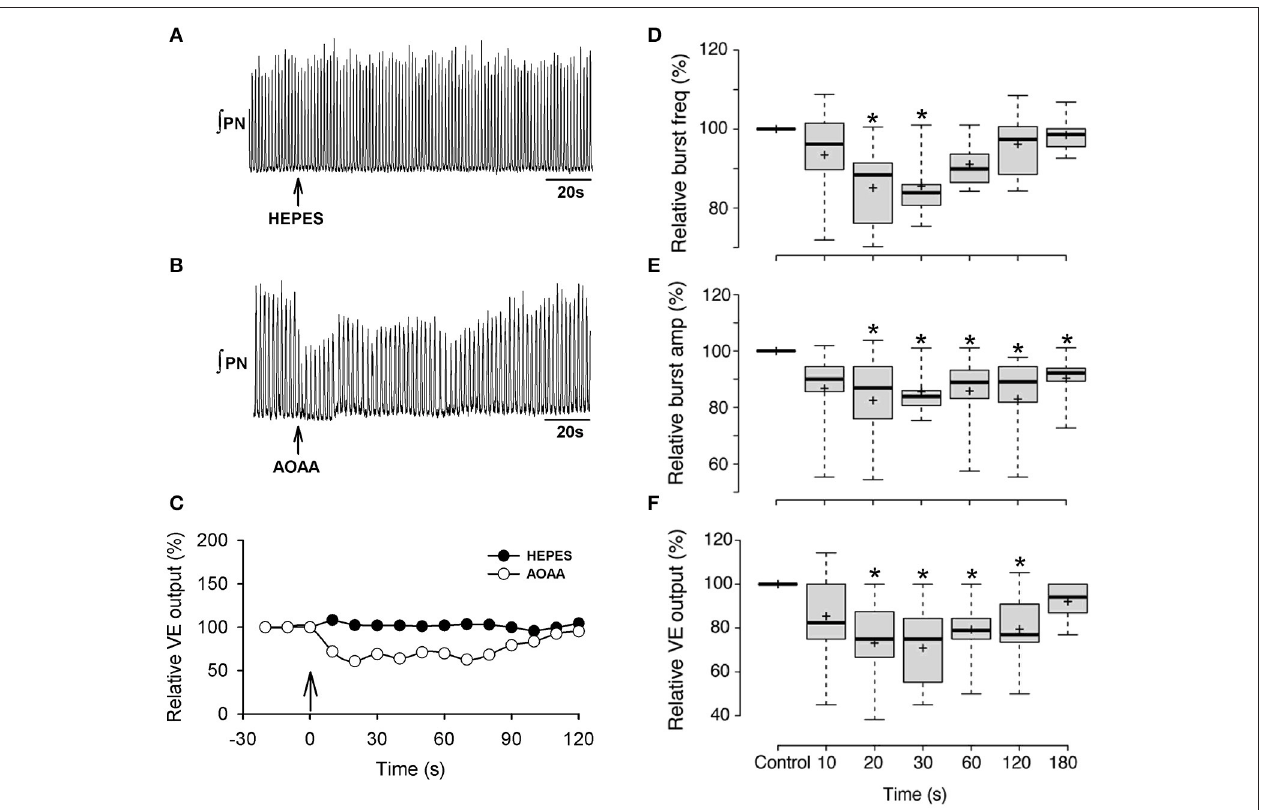
FIGURE 4 | Effect on phrenic nerve activity of unilateral microinjection of AOAA into the preBötC of anesthetized, paralyzed rats breathing control gas (25% O 2 , balance N 2 ). Representative recording of phrenic nerve activity showing the effects of local HEPES (A) or AOAA ( B ; 1mM, 250nL) microinjection into the preBötC on nerve output and ventilatory output for the same animal (vertical arrow in (C) represents onset of HEPES or AOAA injection) (C) . Box plots of group data showing the time course of changes in burst frequency (D) , burst amplitude (E) and ventilatory output (F) evoked by unilateral preBötC AOAA (1mM, 250nL, n = 10). The symbol *indicates difference ( p < 0.05) compared to